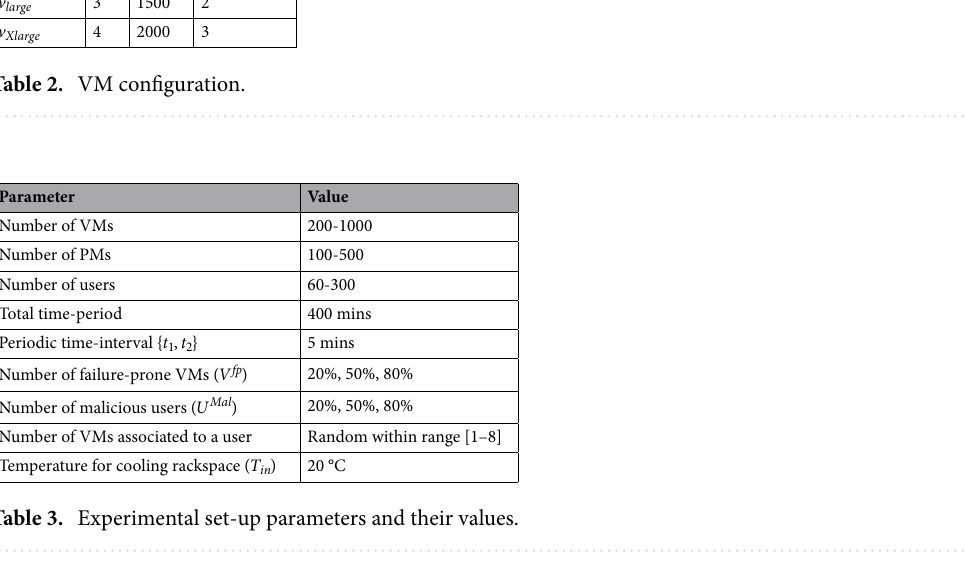
Table 4. Performance metrics for GCD workloads. ̟ usage efficiency, CFR : carbon foot-print rate, RCR : resource contention rate, (cid:31) : probability of co-residency attack, PW : power consumption, RU : resource utilization, Mig # : number of VM migrations, SLA